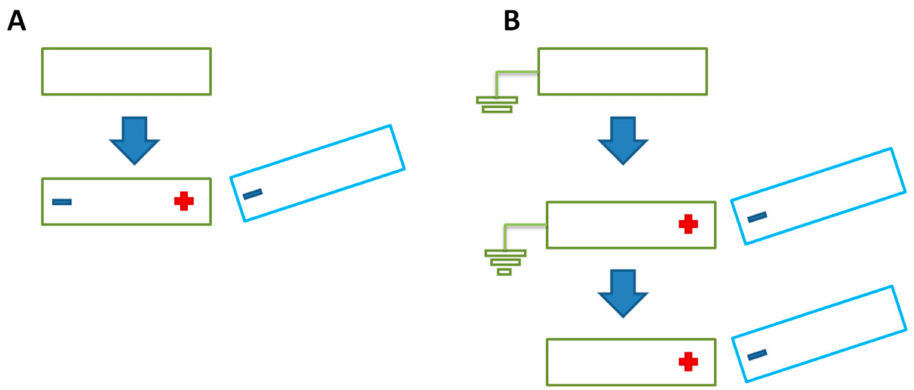
Figure 5. Schematic illustration of electrostatic induction processes. Panel ( A ) ungrounded object. Panel ( B ) grounded object. Legend: external charged materials (cyan) and initially uncharged material